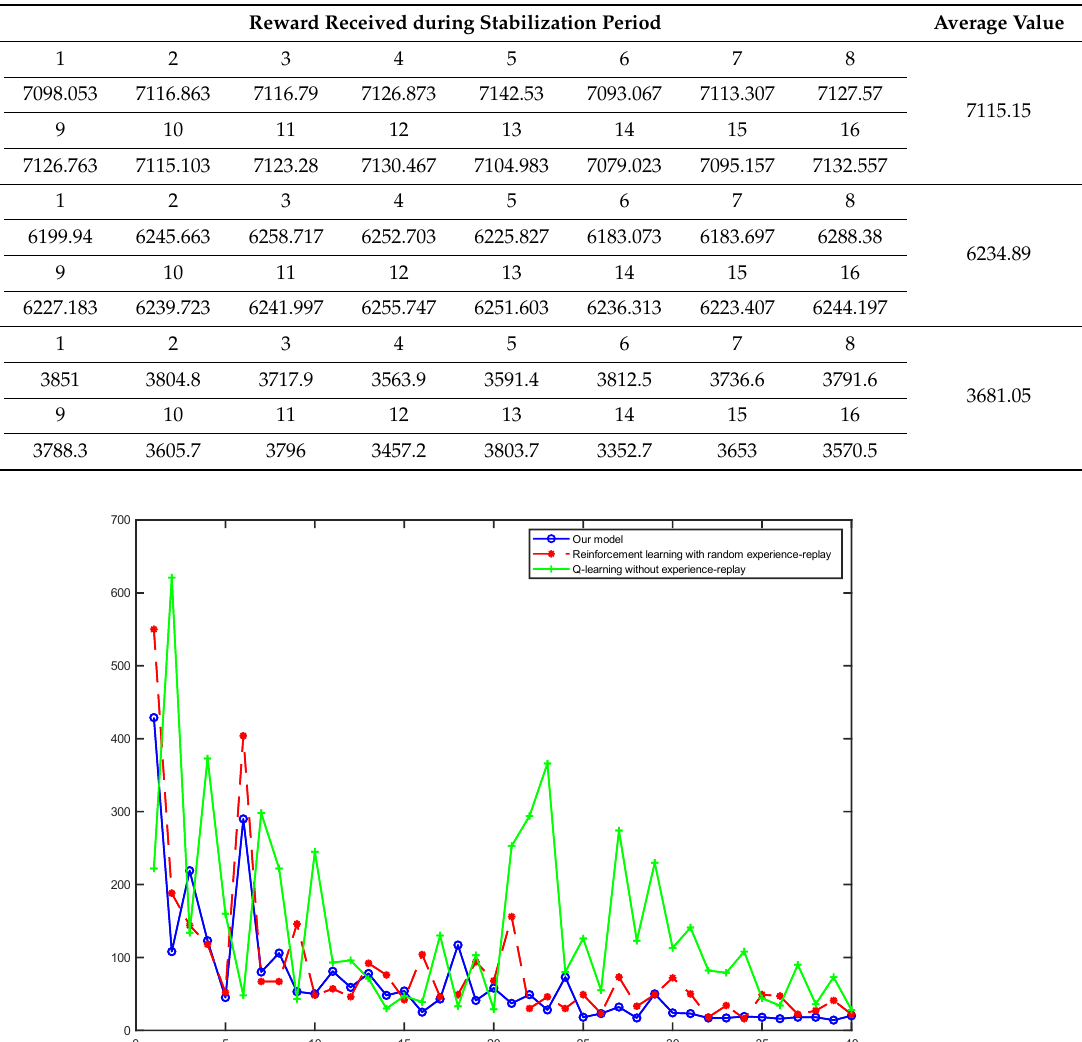
from the lower left corner and the target task is to reach the blue survival platform in the upper right corner with a shorter